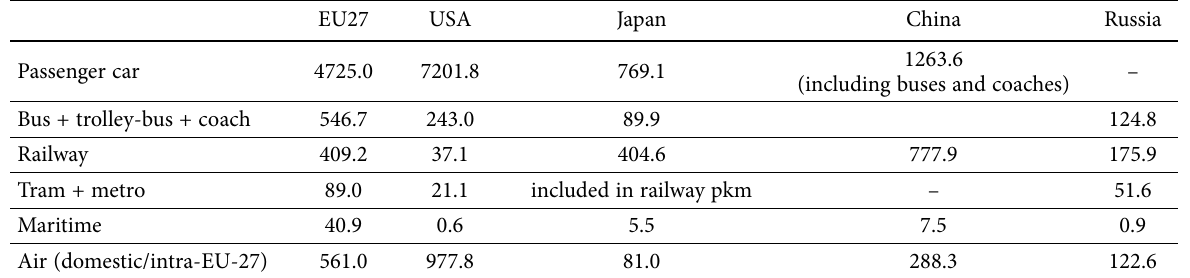
Table 1. Worldwide 2008 passenger transport values [billion pkm] (EC 2011a)